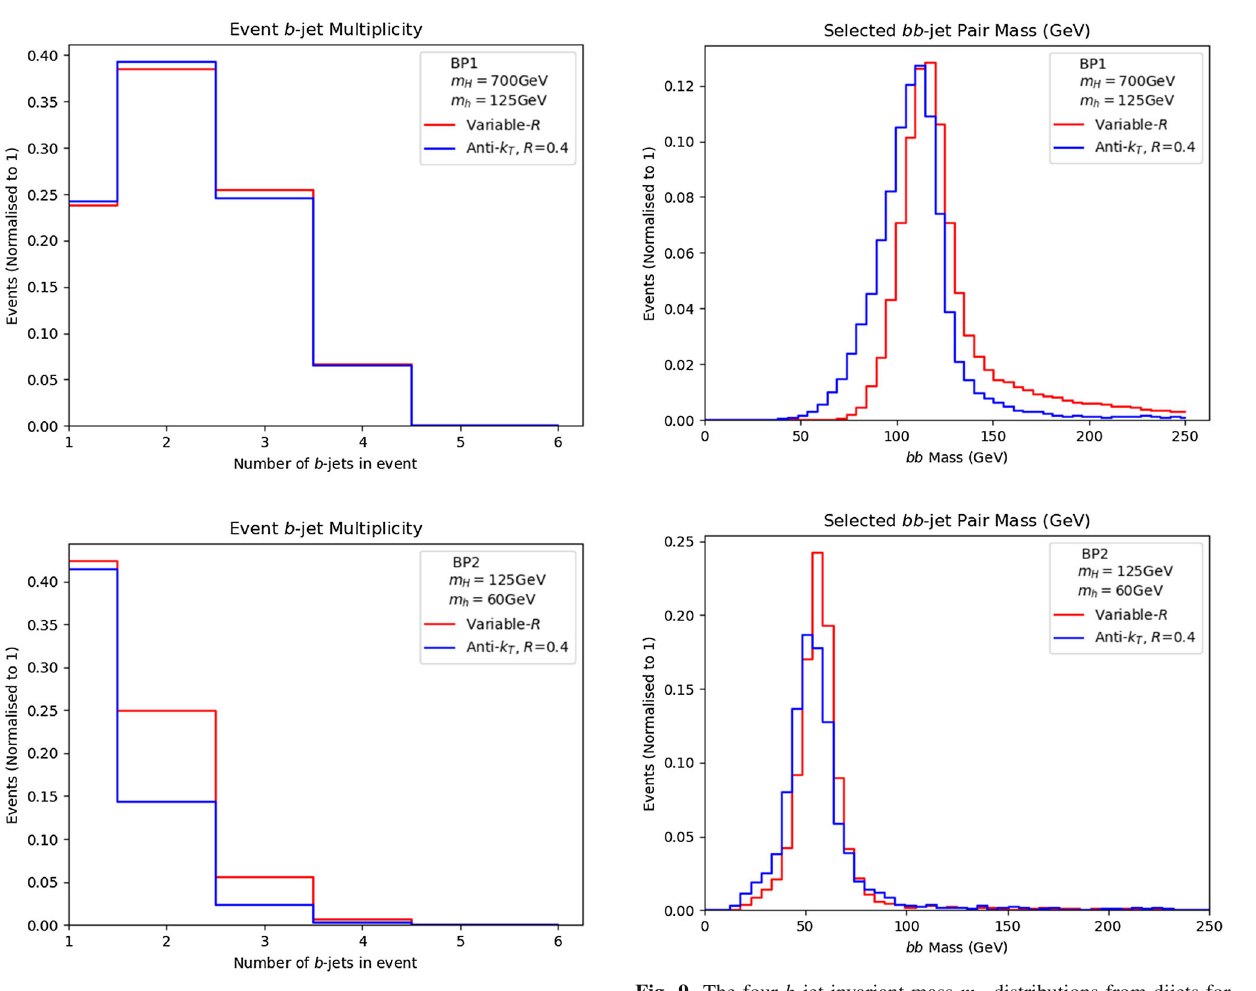
Fig. 8 Upper panel: the b -jet multiplicity distributions for BP1. Lower panel: for BP2 these.) For variable- R , we use ρ = 100 GeV for BP1 and